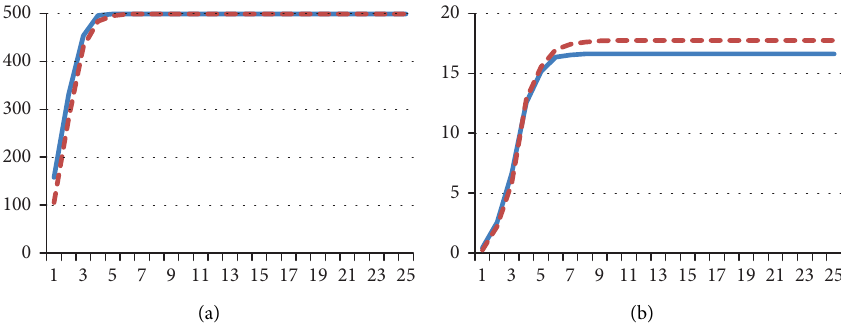
, and the green line represents C 1 2